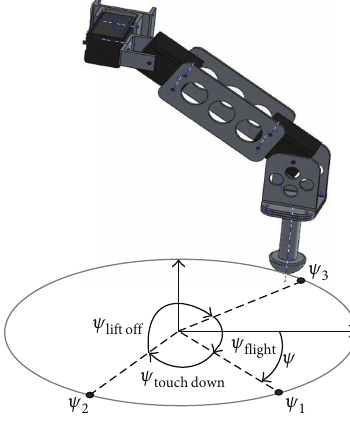
Figure 2: State phases and transition angles of